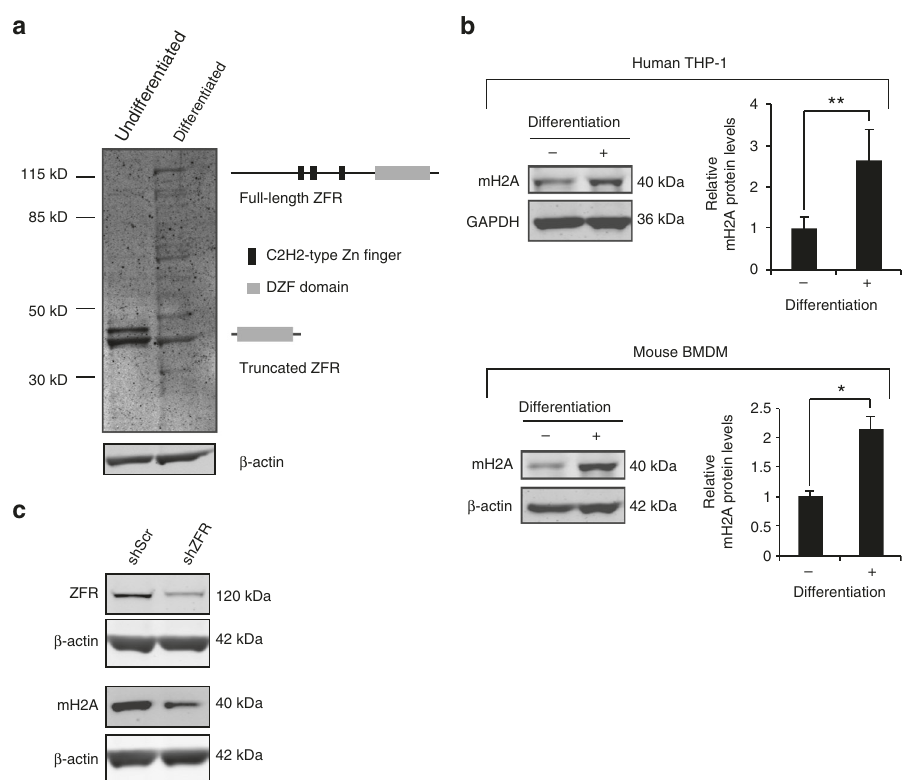
Fig. 3 Regulation of ZFR and mH2A1 in macrophage differentiation. a Immunoblot analysis of alternative ZFR isoforms expression in monocytic and macrophage-like THP-1 cells, using an antibody against the C-terminal DZF domain. Schematics illustrate putative proteins generated by full-length and truncated ZFR isoforms arising from alternative promoters. b Immunoblot analysis of mH2A1 in human THP-1 cells (top) and murine BMDMs (bottom) before and after differentiation. Graphs represent quanti fi cation of mH2A1 protein levels in human THP-1 cells ( n = 3) and mouse BMDMs ( n = 2), with GAPDH as a control. c Immunoblot analysis of ZFR and mH2A1 in THP-1 cells stably transduced with shRNAs speci fi c to ZFR (shZFR) or non-targeting control shRNAs (shScr). Approximate MW based on size markers is shown. Graphs indicate mean ± SD; * P < 0.05, ** P < 0.01 (two-tailed Student ’ s t